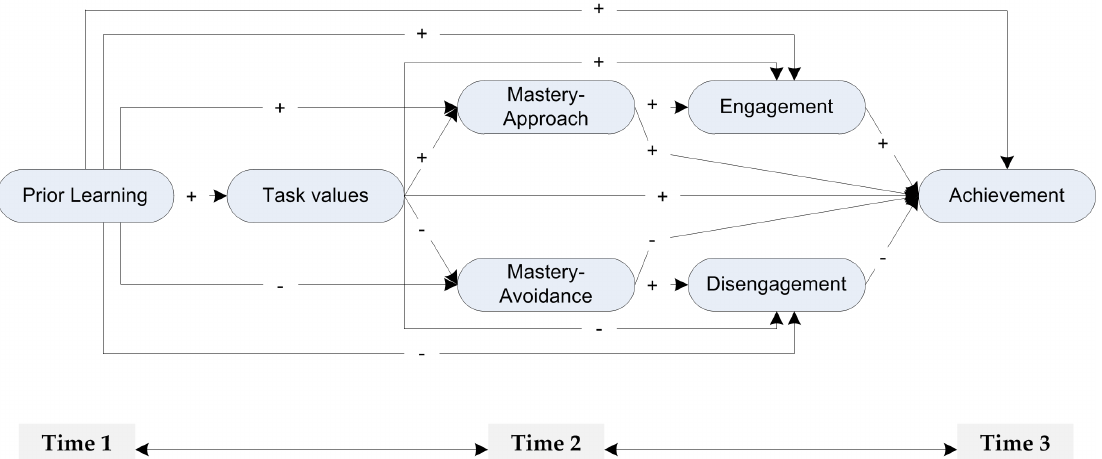
Figure 1. A conceptual framework of mastery goals, task value, and academic engagement-disengagement. Note. ‘+’ denotes a positive relationship between the variables (e.g., the positive effect of task value on a mastery-approach), whereas ‘-’ denotes a negative relation (e.g., the positive effect of task value on a